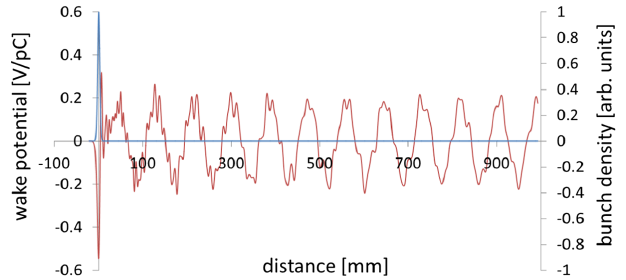
FIG. 11. Wake potential (red line) of a 2.5 mm bunch in model 3. The blue line shows bunch linear charge density